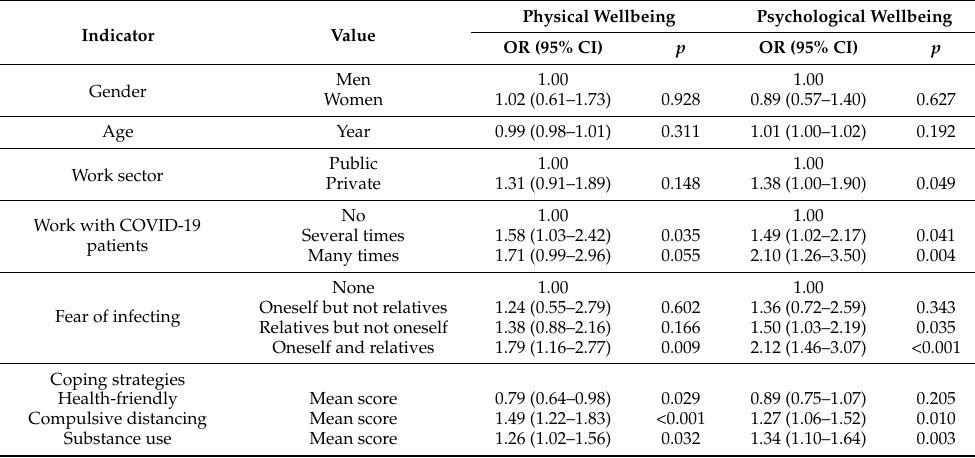
Table 4. Predictors of subjective wellbeing decrease: multivariate logistic